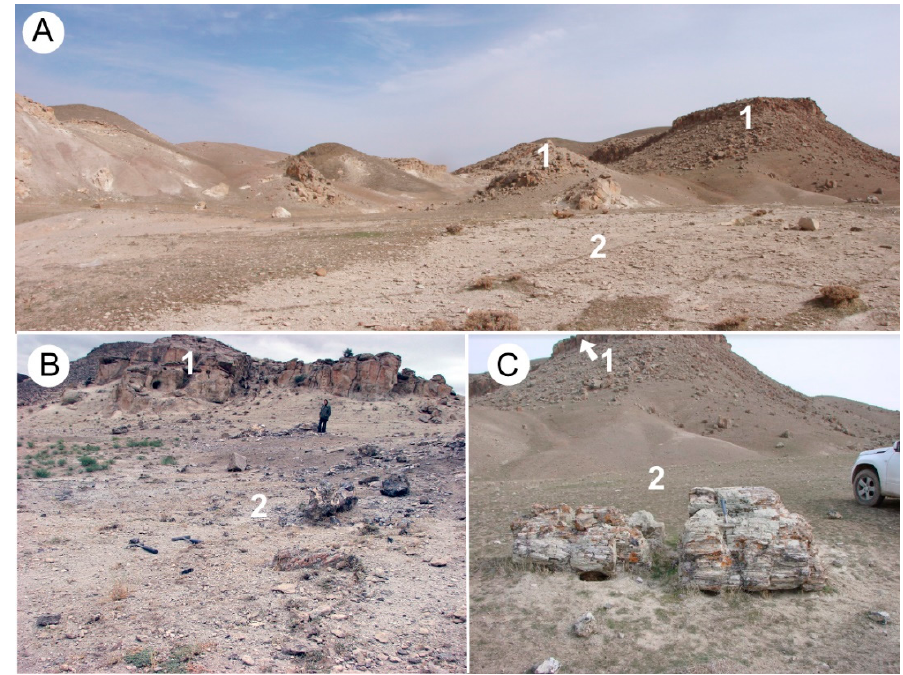
Figure 2. Outcrops of sedimentary and volcanic units in the study area. ( A , B ) General views of fossil site, showing dark-colored capping layer (1) and light-colored tuffite-containing fossil wood (2). ( C ) Fossil trunk 4, sample #T-5.